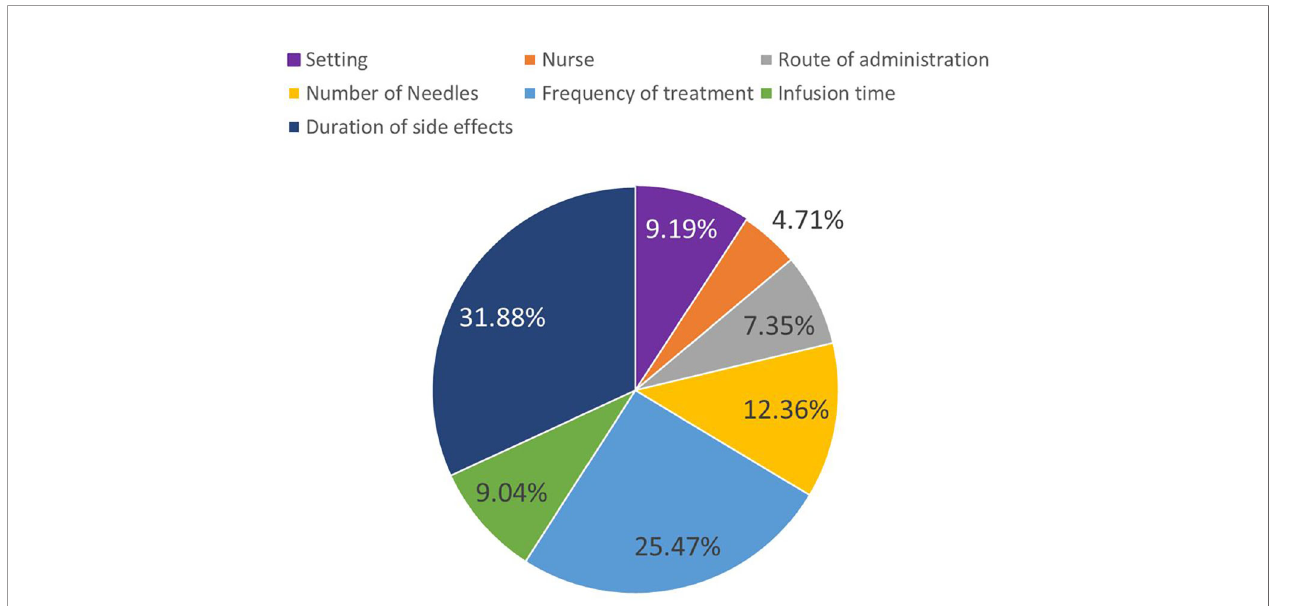
FIGURE 3 | Overall attribute importance. Overall attribute importance weights depict the most in fl uence an attribute change had on treatment choices. This is based on the biggest preference-weight difference within each